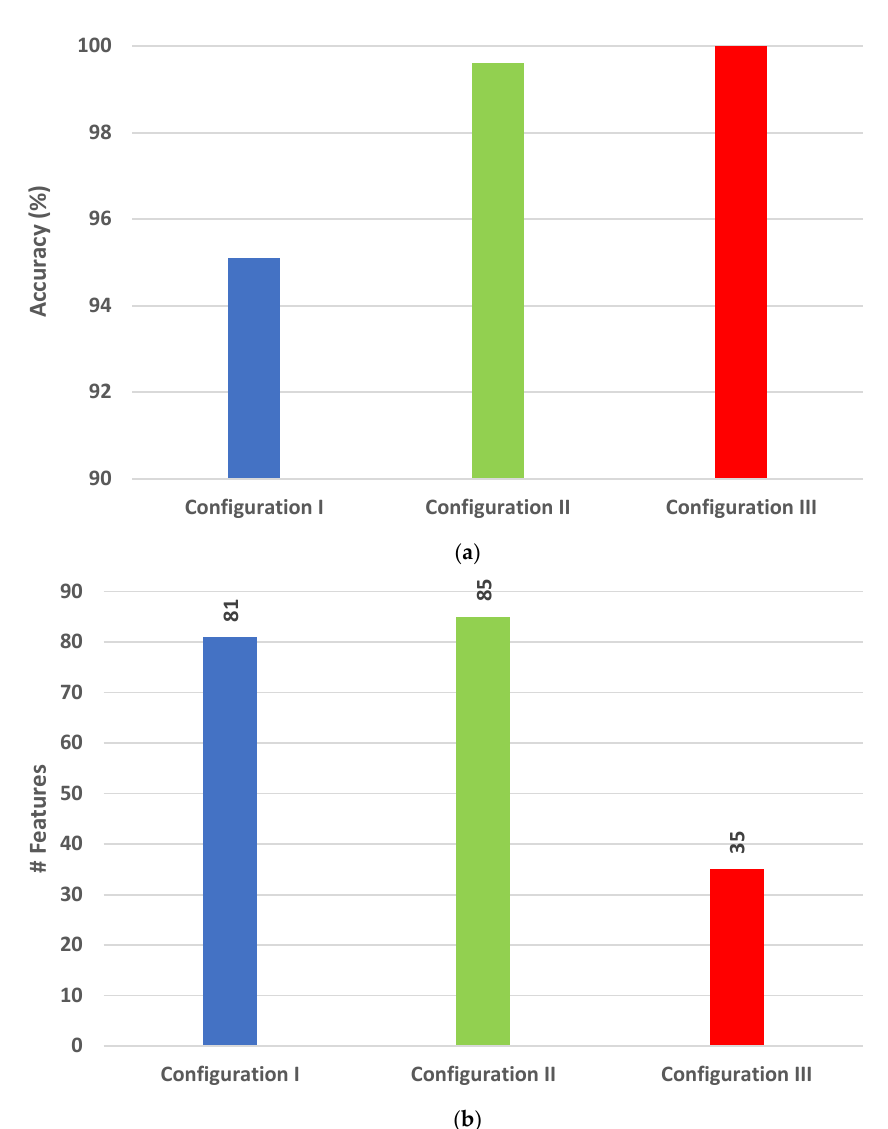
Figure 5. A comparison between ( a ) the highest accuracy reached in each configuration and ( b ) the number of features used to train the SVMs.